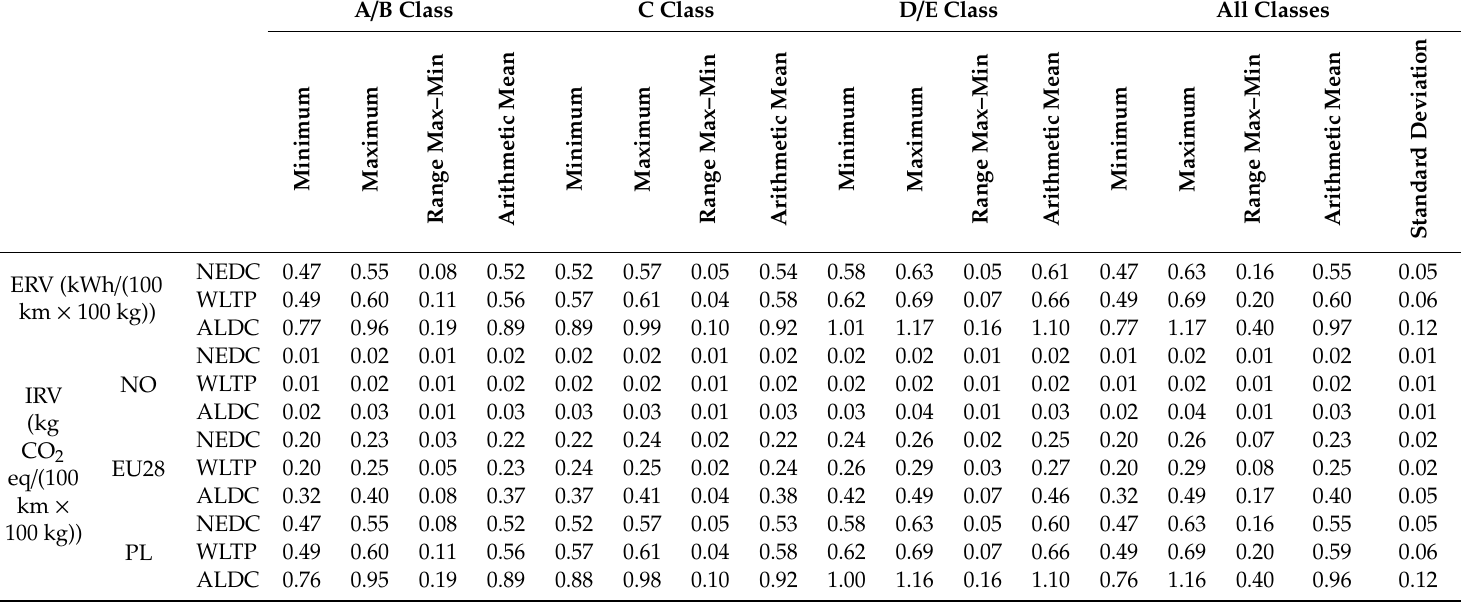
Table 2. Analysis of ERV and IRV per car class / driving cycle in terms of minimum and maximum value, size of range max–min, arithmetic mean, and standard